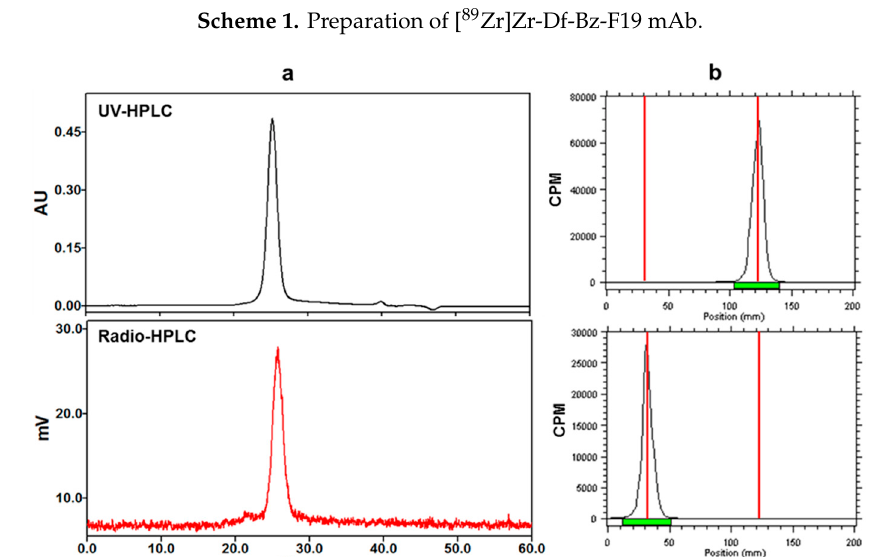
Figure 1. Quality control of [ 89 Zr]Zr-Df-Bz-F19. ( a ) UV-HPLC chromatogram (280 nm) of Df-Bz-F19 (top) compared with radio-HPLC chromatogram of [ 89 Zr]Zr-Df-Bz-F19 (bottom). Chromatograms demonstrate that [ 89 Zr]Zr-Df-Bz-F19 can be prepared with high purity. The radiotracer also demonstrates the same retention time as the unlabeled antibody; ( b ) Radio-ITLC of [ 89 Zr]Zr(ox) 2 (top), and [ 89 Zr]Zr-Df-Bz-F19 (bottom). In this ITLC-SG system, unchelated [ 89 Zr]Zr(ox) 2 was complexed by the eluent EDTA to form [ 89 Zr]Zr-EDTA, which eluted with the solvent front (R f ~ 1), while [ 89 Zr]Zr-Df-Bz-F19 remained at the origin (R f ~ 0).